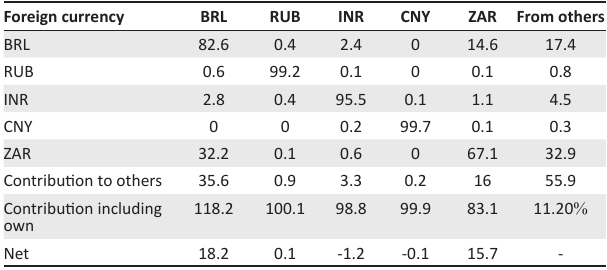
TABLE 4: Static spillover (connectedness) –